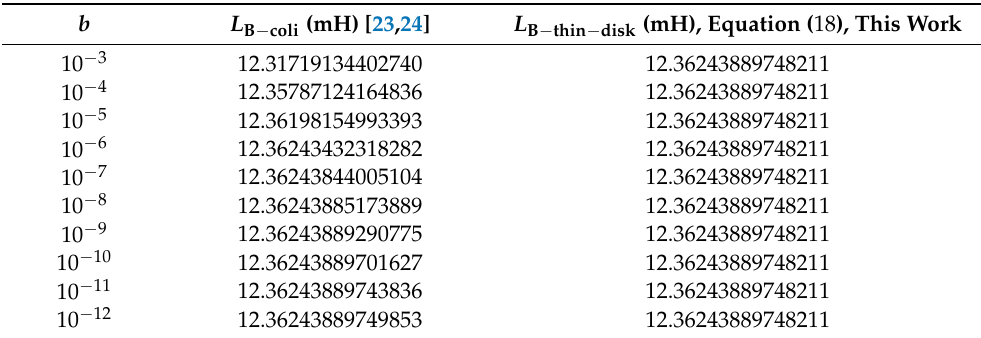
Table 7. The self-inductance for the real Bitter coil and the thin Bitter disk coil with strongly varying